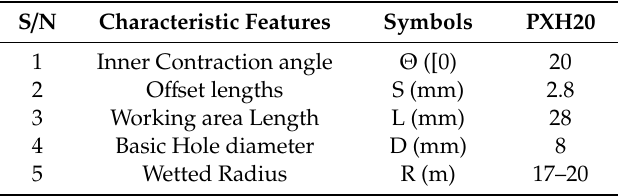
Table 1. Design specifications of the fluidic sprinkler